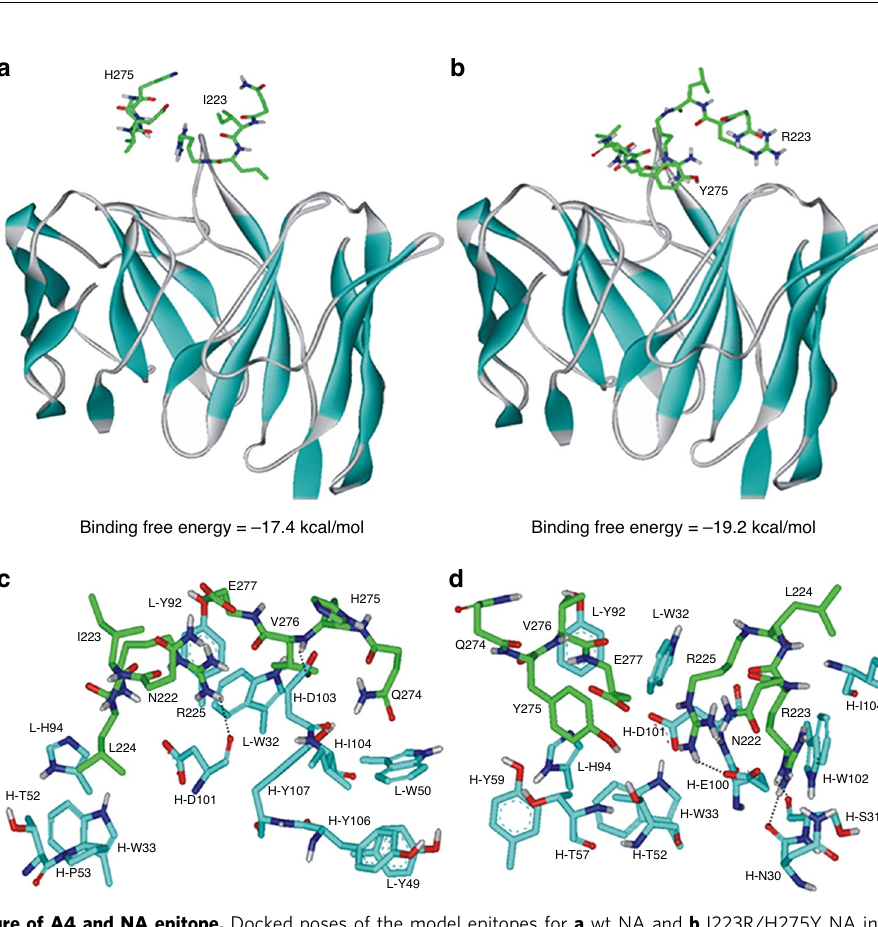
Fig. 3 Structural feature of A4 and NA epitope. Docked poses of the model epitopes for a wt NA and b I223R/H275Y NA in CDR of A4. Calculated binding modes of the model epitopes for c wt NA and d I223R/H275Y NA in CDR of A4. The β -strands of A4 and carbon atoms of NA epitopes are indicated in cyan and green, respectively. Dotted lines indicate the hydrogen bonds.